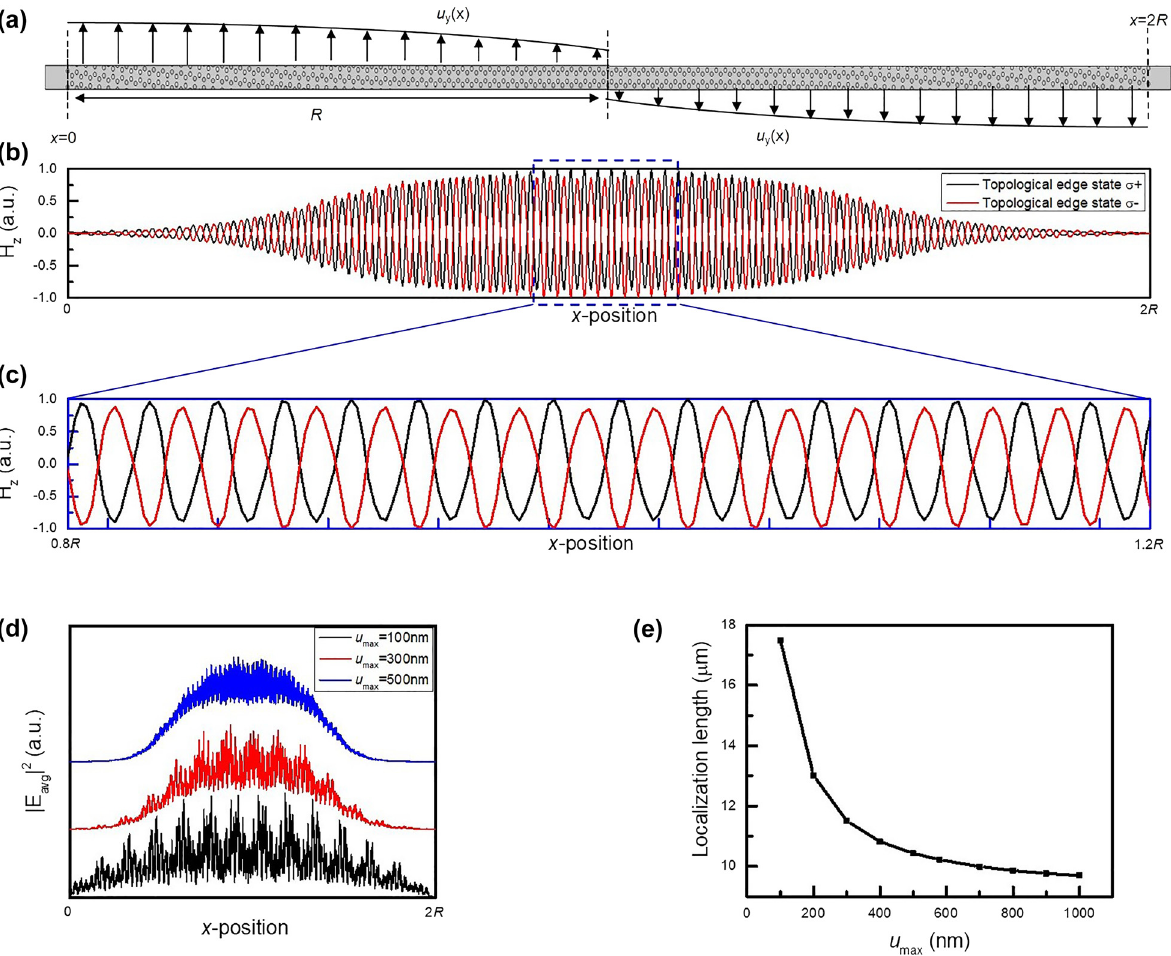
Figure 5: The parity of topological edge states and the tunability based on the strength of the pseudo-magnetic field. (a) The supercell of the chiral structure, which has Ander periods in the x -direction and maintains periodic in the y -direction. (b), (c) The distributionof H z componentinthe x -direction,whichisaveragedalongthe y -directioninasupercell.Theblackandredlinerepresenttheedge state σ + and σ − showninFigure3,respectively,andtheenlargedbluedashbox isshowninc.(d)The | E avg | 2 of edgestate σ + in u max =100nm, 300 nm, and 500 nm. (e) The mode localization as the function of u max